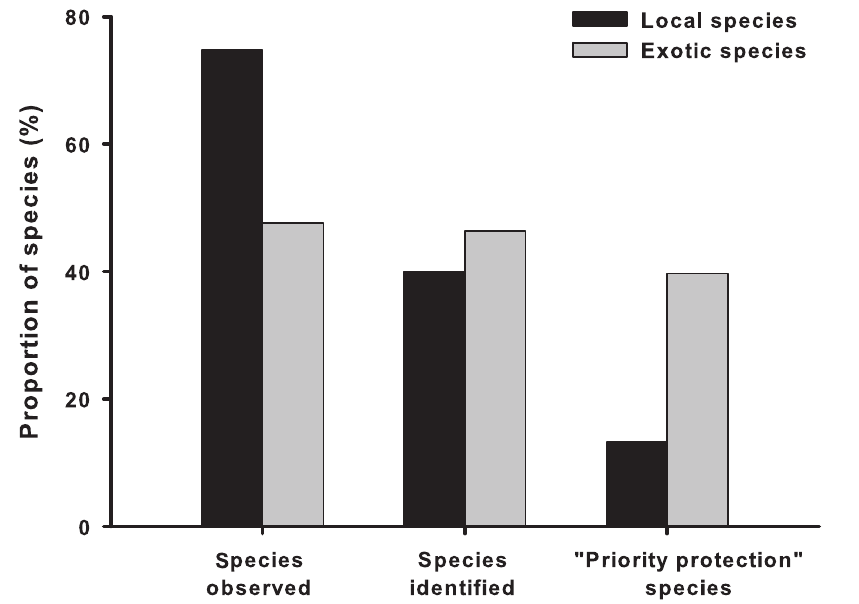
Figure 2. Local vs. exotic biodiversity. Proportion of exotic (grey bars) and local (black bars) species for which live specimens have been seen/ observed by schoolchildren (‘‘Species observed’’), that were successfully identified by schoolchildren (‘‘Species identified’’) and that were perceived as ‘‘priority protection’’ by schoolchildren (‘‘Priority protection species’’). See text for details.